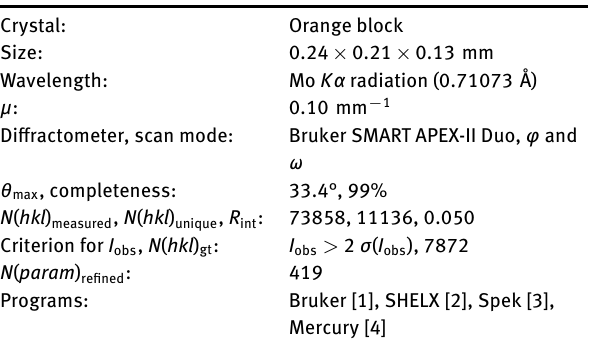
Table 1: Data collection and handling.